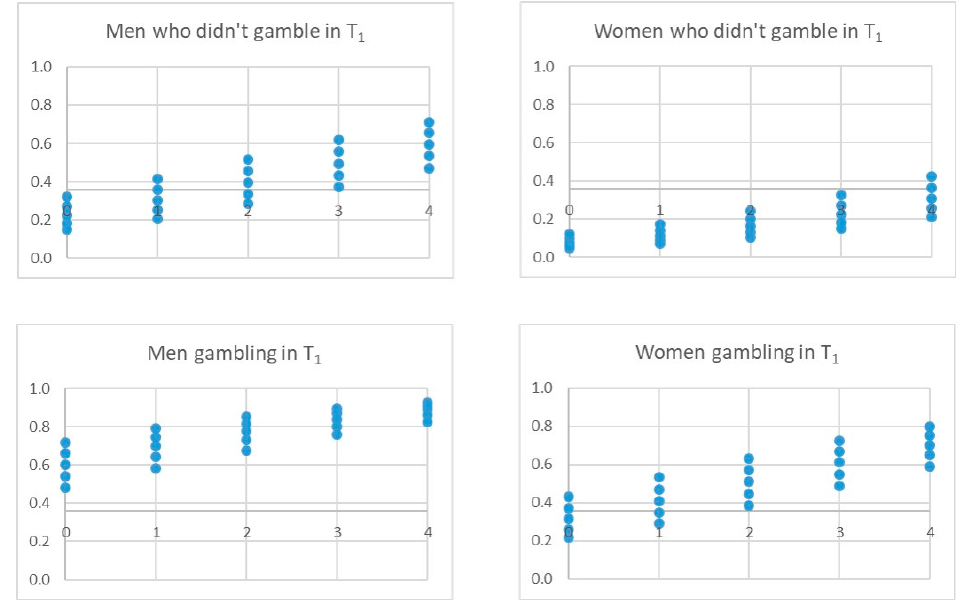
Figure 7. Possible scenarios for model A. Note. The X-axis represents the values of the variable risk perception (0, 4). The dots represent the score on the sensation-seeking variable. The horizontal line represents the threshold for a person to be classified as a gambler or not at T 2 .